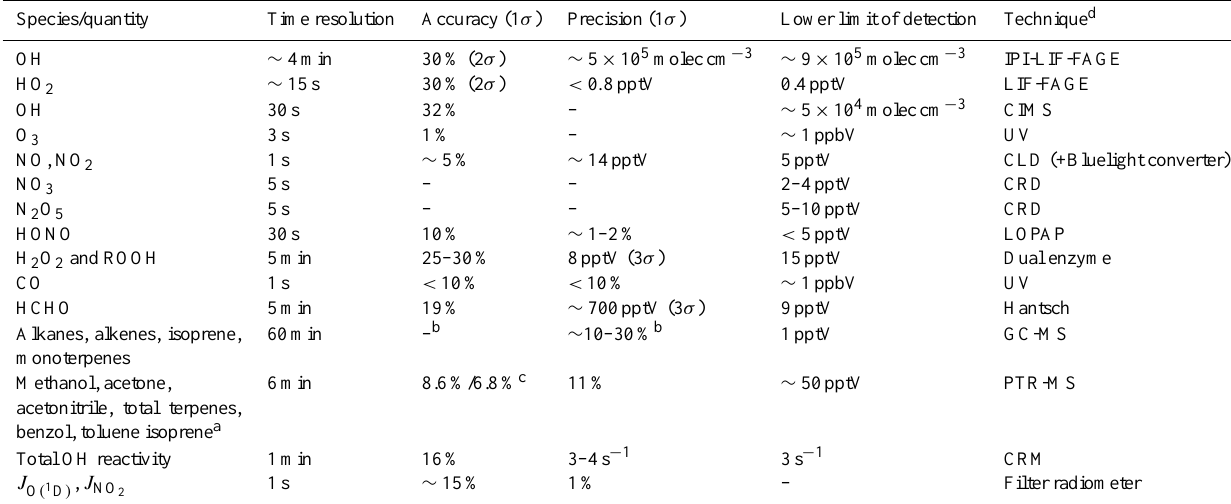
Table 1. Instrumentation applied during HUMPPA-COPEC2010.